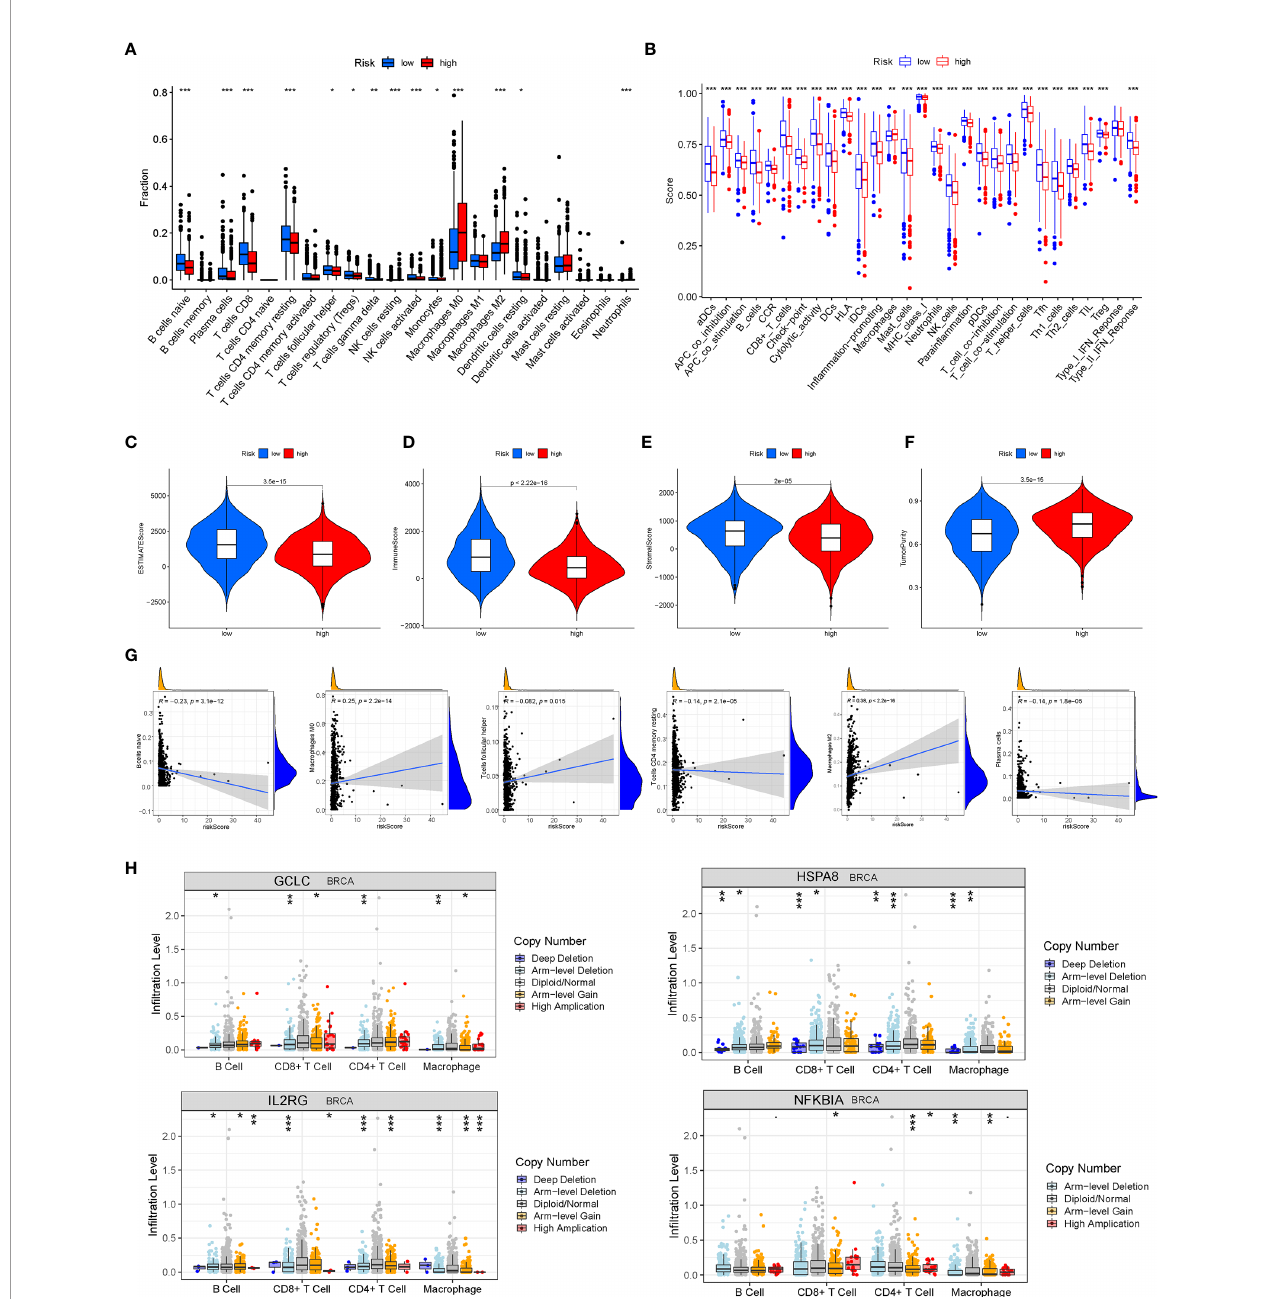
FIGURE 9 | Analysis of tumor microenvironment (TME) and tumor immunity. The different distributions of the immune cell in fi ltration (A) and the immune function (B) between the high- and low-risk groups. (C – F) The Immune score, the Stromal score, the tumor purity, and the ESTIMATE score were applied to quantify the different immune statuses between the high- and low-risk groups. (G) Pearson ’ s correlation between six kinds of immune cells and the risk score. (H) The relationship between copy number variations (CNVs) of four aging-related genes (AGs) ( GCLC, HSPA8, IL2RG , and NFKBIA ) and the level of in fi ltration of B cells, T cells, and macrophages in breast cancer (BC). *P < 0.05; **P < 0.01; ***P <